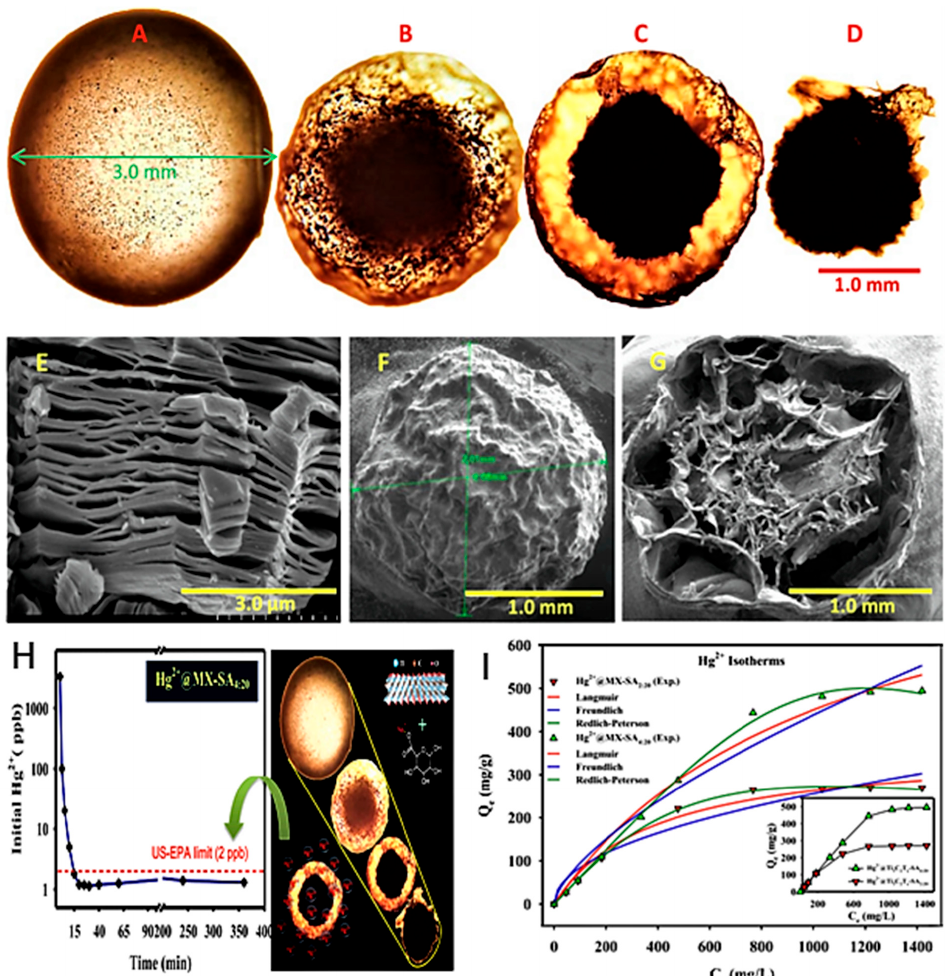
Figure 10. Optical microscopic images of an MX-SA4:20 ( a ) hydrogel sphere (3 mm), ( b ) following vacuum freeze-drying (~2 mm), ( c ) cross-sectional view, and ( d ) core of MX-SA4:20 spheres. SEM images of ( e ) Ti 3 C 2 T x MXene, ( f ) dried MX-SA4:20 sphere, and ( g ) internal structure of sphere cross-section. (h) Kinetics of removal of Hg 2+ from tap water by MX-SA4:20. (i) Adsorption isotherm of Hg 2+ onto MX-SA2:20 and MX-SA4:20. Adapted and reproduced with permission from [62] . Copyright 2019 Elsevier.